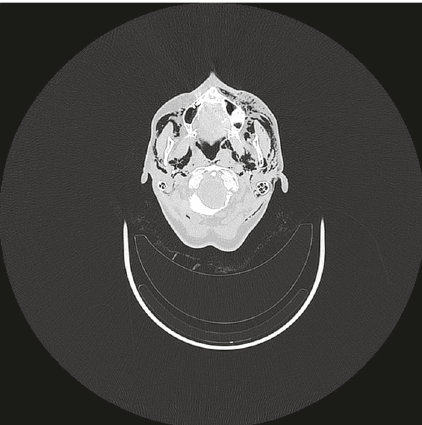
Figure 3: Computed tomographic axial view of the emphysema in the upper thorax, splaying the vascular bundle and running posterior to the clavicles with widening of the pectoral muscles.